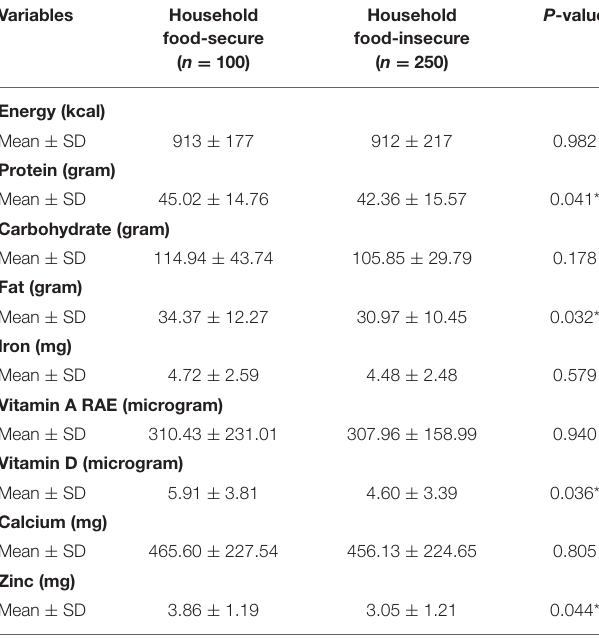
TABLE 3 | Energy, macro and micronutrients intake among under-five children by food security status ( n = 350).